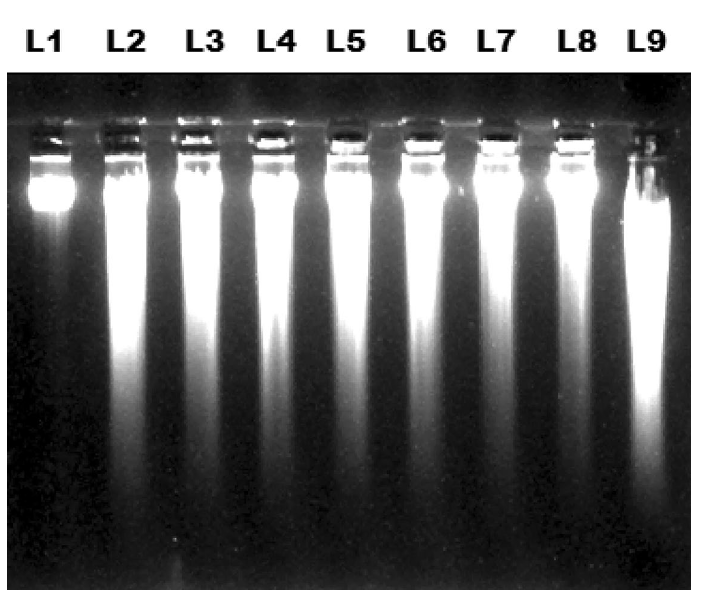
Figure 6. DNA damage inhibition on NSE after treatment with various concentrations of sodium azide. L1 Standard calf thymus DNA; L2, L3, L4, L5, L6, L7, L8 representing calf thymus DNA and NSEs after 0 (Control), 5, 10, 20, 50, 100, 200 µM treatment of sodium azide, respectively; L9 showing calf thymus DNA with 1 mM